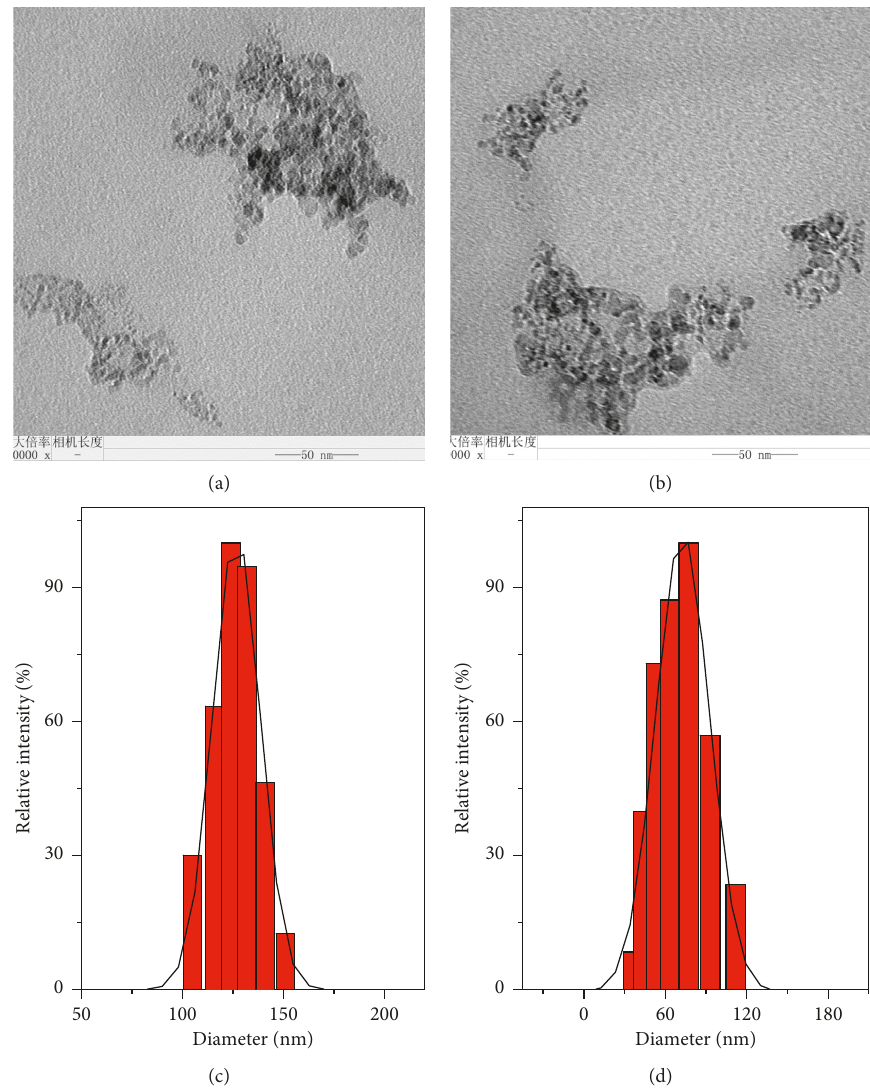
Figure 1: TEM images of NDs (a) and HSA-NDs complex (b). Size distributions of NDs (c) and HSA-NDs complex (d) in 0.01M PBS determined by DLS. (cNDs � 16.0mg · L − 1; cHSA � 2.0 μ